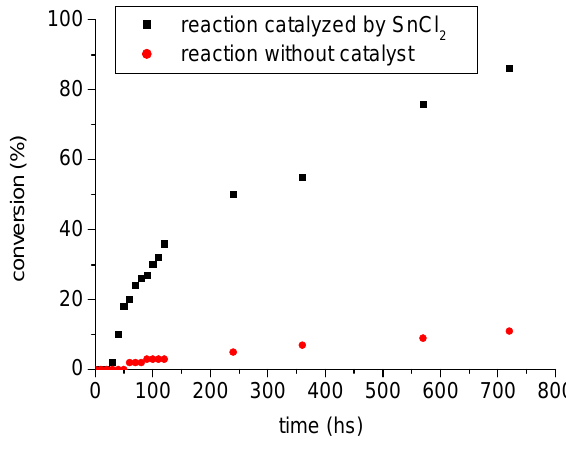
Figure 1. Trend of conversion of oleic acid into ethyl